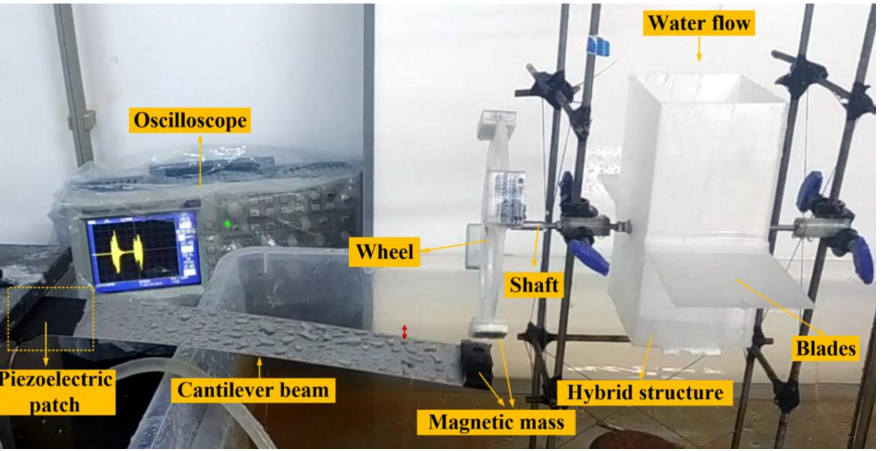
Figure 6. Experimental set-up of the hydroelectric energy harvesting application using the proposed hybrid